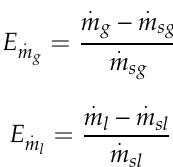
Figure 8. The deviations relative to GVF after correction by the proposed compensation model. ( a ) Relative deviations of density. ( b ) Relative deviations of mass flow.